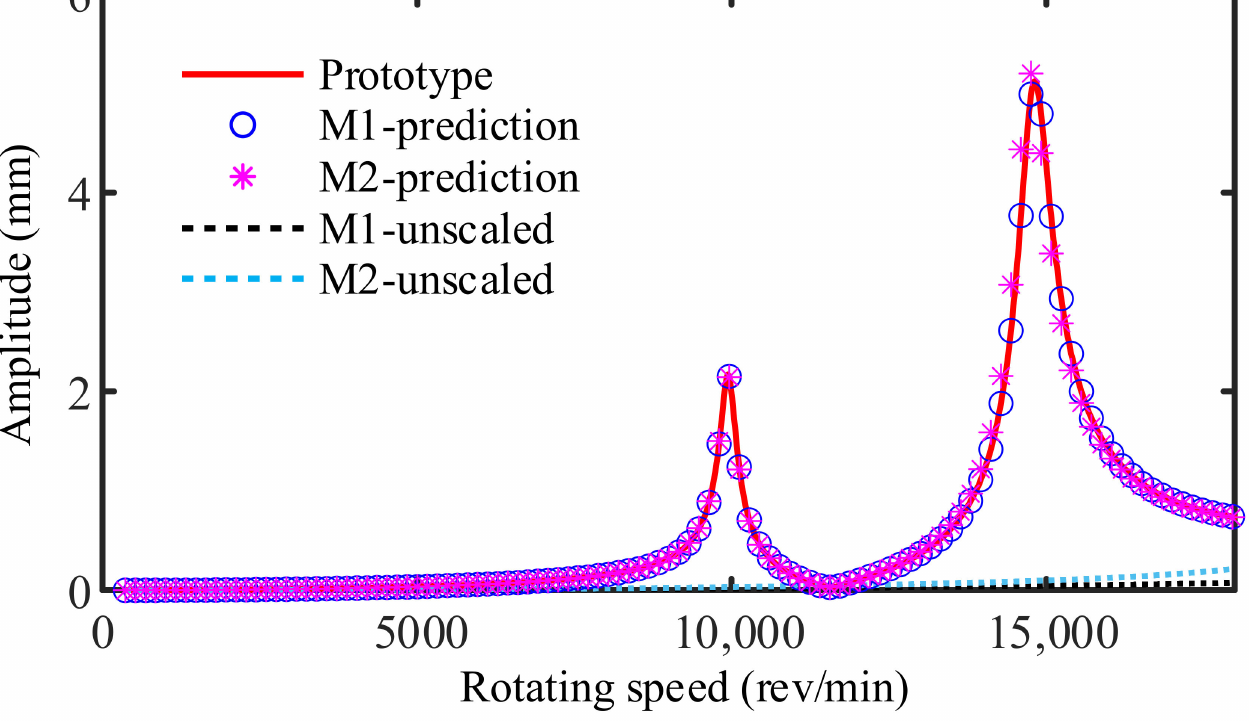
Figure 11. Prediction of AFR from M1 and M2 under LP rotor